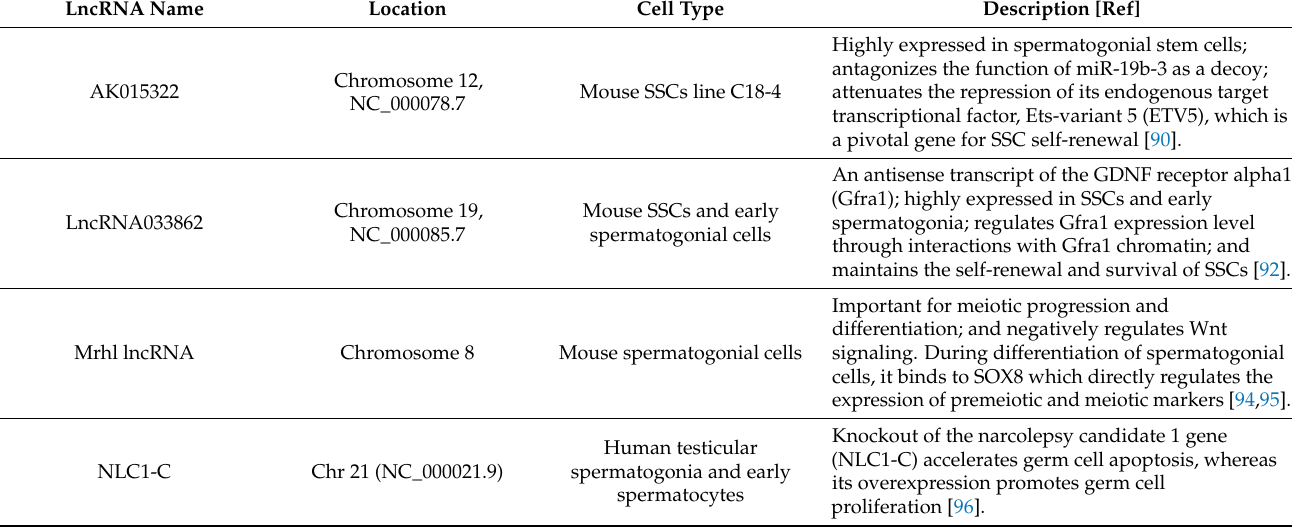
Table 1. Recent findings relating to the roles of long noncoding RNAs (lncRNAs) and their functions in spermatogonial stem cells